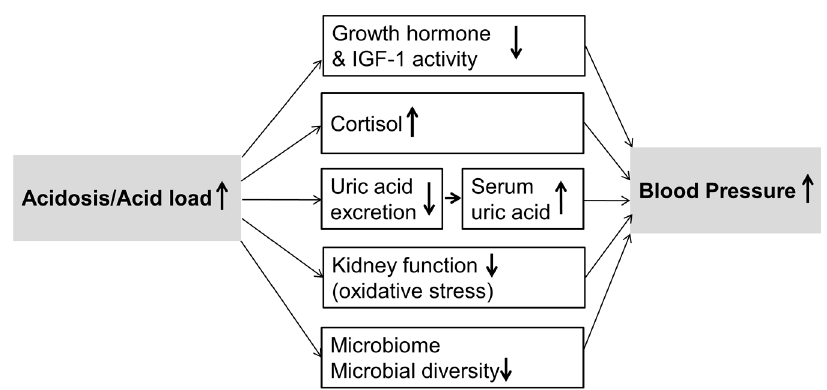
Figure 2. Discussed mechanisms involved in blood pressure changes due to an altered acid–base status of which particularly a potentially altered microbiome requires further experimental confirmation. IGF-1, insulin-like growth factor-1.